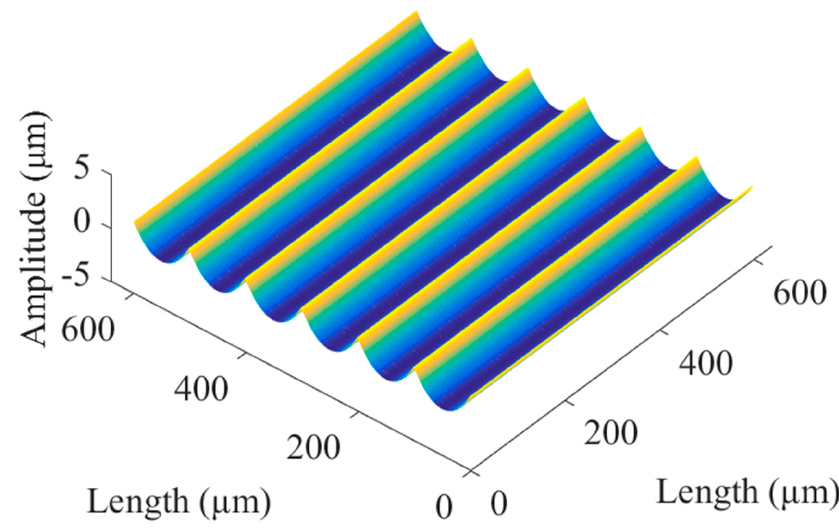
Figure 3. Texture Figure 3. Texture model.